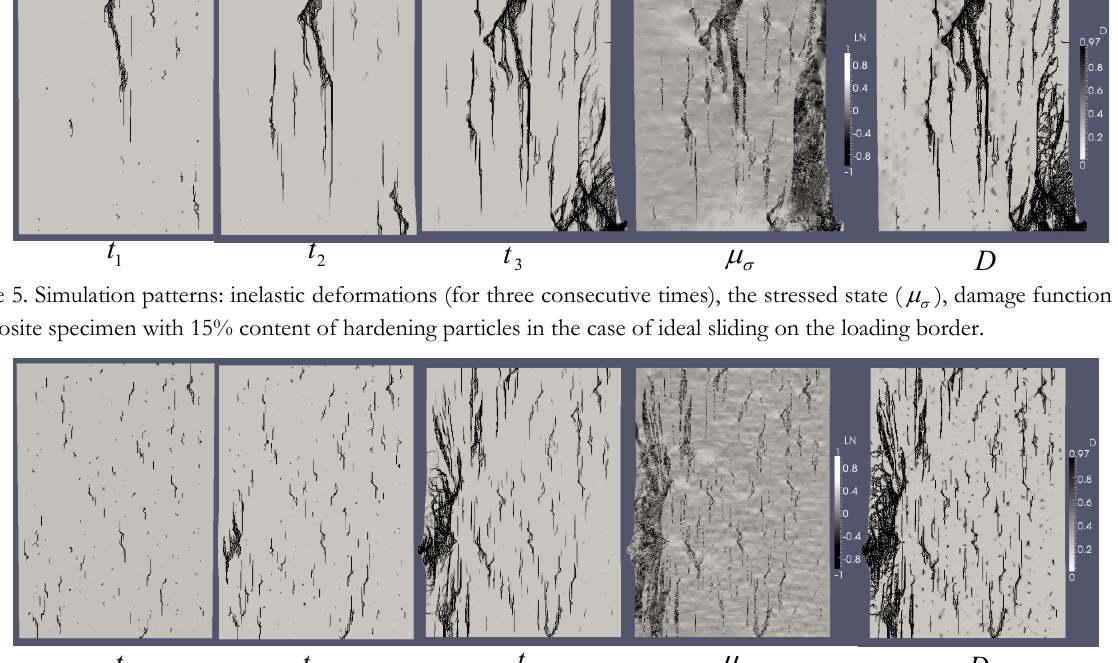
Figure 6: Simulation patterns: inelastic deformations (for three consecutive times), the stressed state ( composite specimen with 40% content of hardening particles in the case of ideal sliding on the loading border.